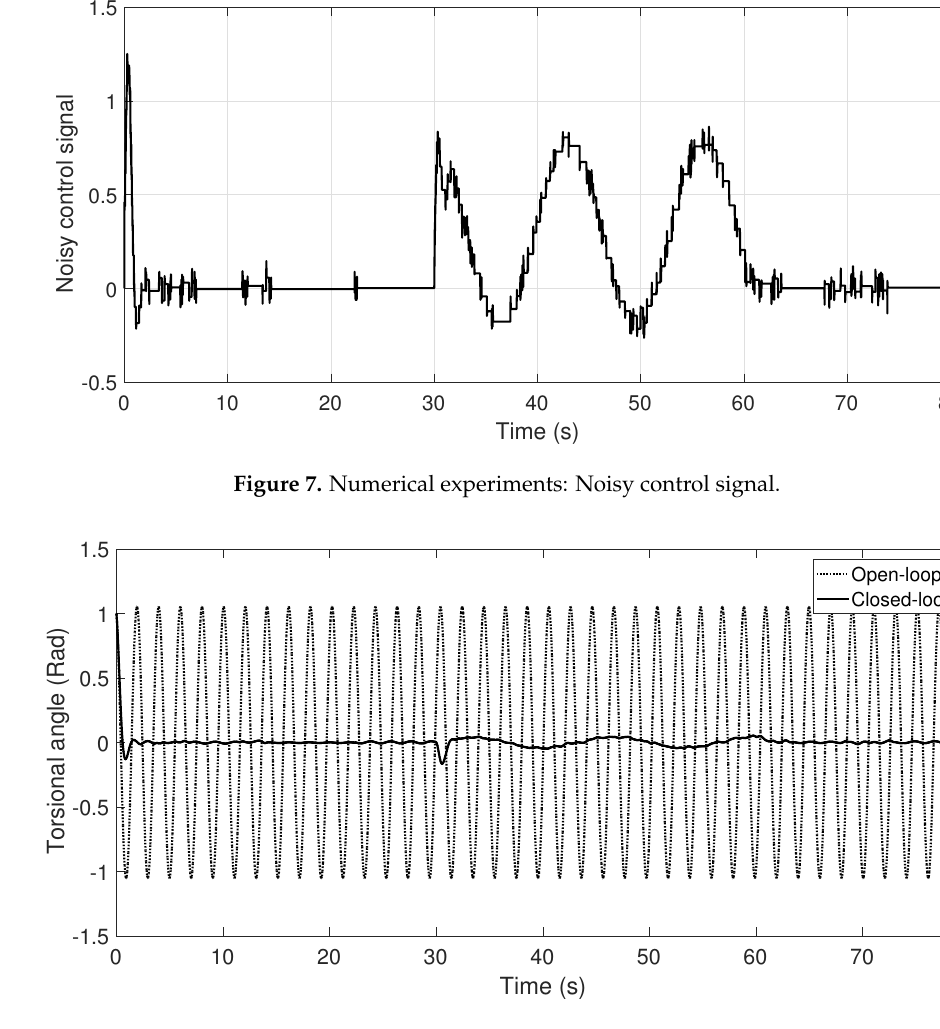
Figure 8. Numerical experiments: torsional angle response for the noisy case.